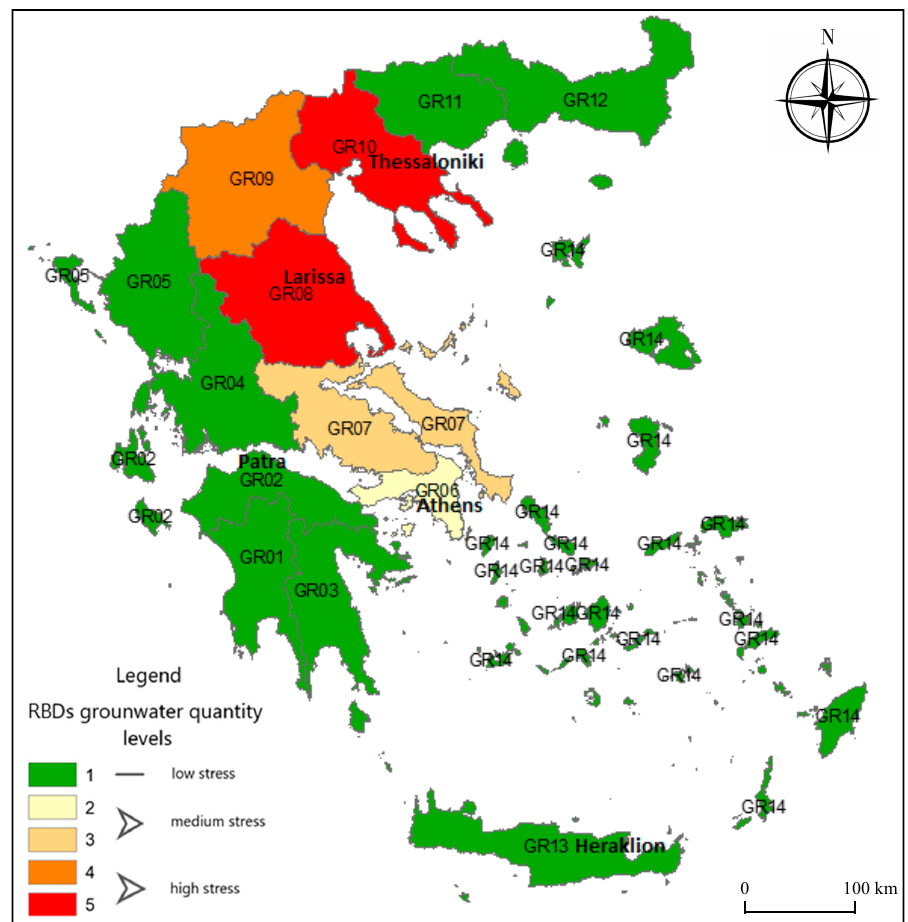
Figure 1. A map of Greece illustrating groundwater stress levels for all RBDs (adjusted from data obtained by the Hellenic Ministry of the Environment and Climate Change, nmwn.ypeka.gr/map).